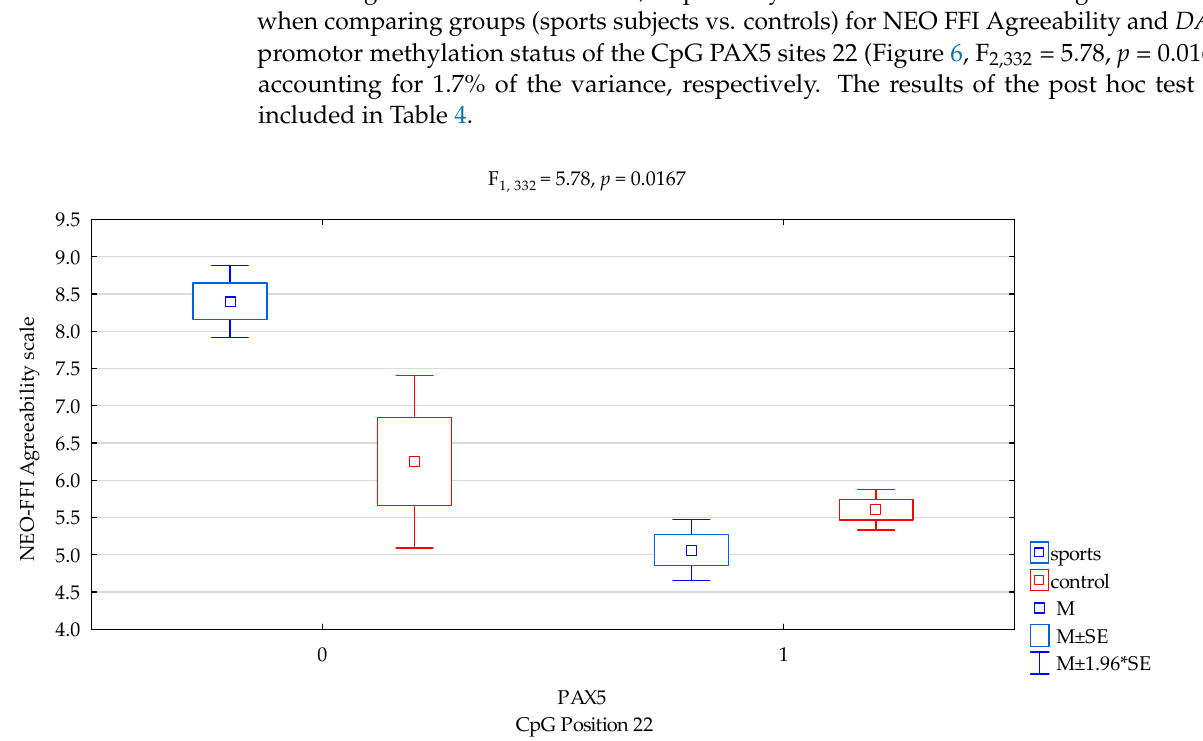
Figure 6. Interaction between sports subjects/control and DAT1 PAX5 CpG sites 22 and NEO FFI Agreeability scale. Methylation status: yes—1, no—0. M ± SE—mean ± standard error, M ± 1.96*SE—mean ± s1.96*standard error.